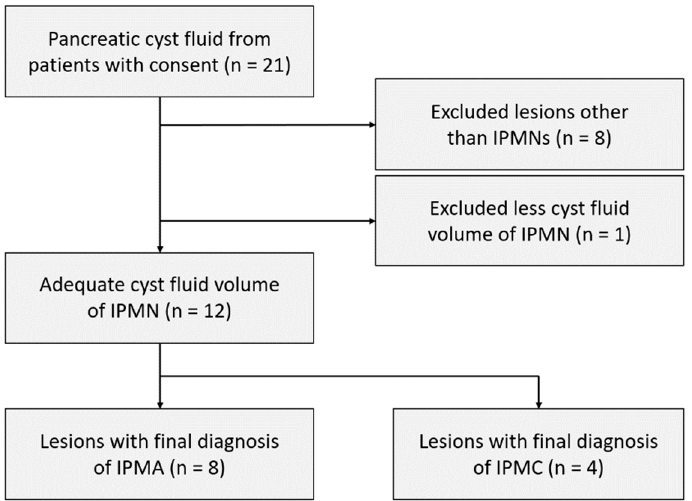
Figure 1. Flow chart of the study samples. IPMA, intraductal papillary mucinous adenoma; IPMC, intraductal papillary mucinous carcinoma; IPMN, intraductal papillary mucinous intraductal papillary mucinous carcinoma; IPMN, intraductal papillary mucinous neoplasm.